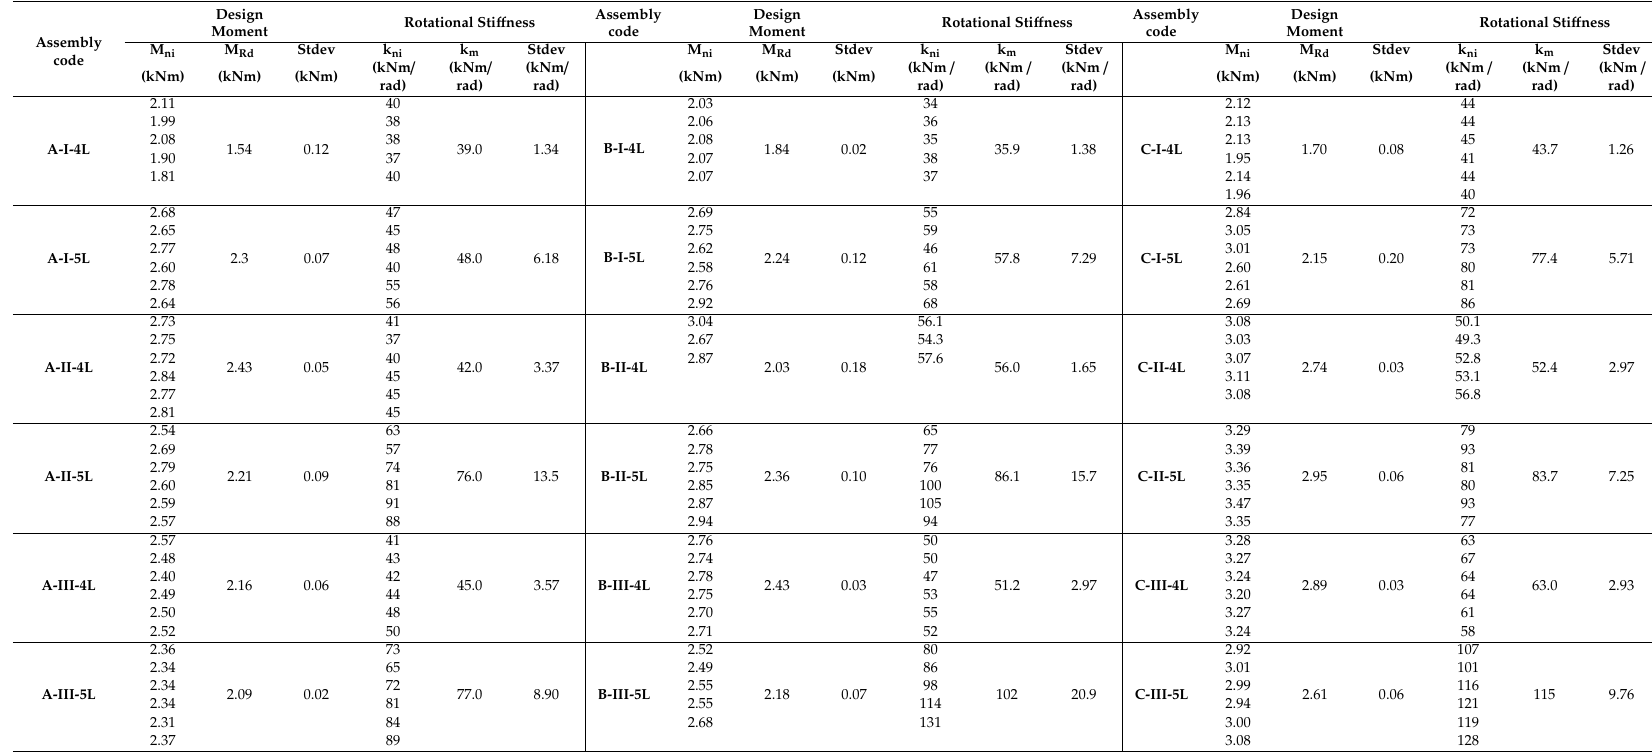
Table 6. Test results in bending tests for all assemblies